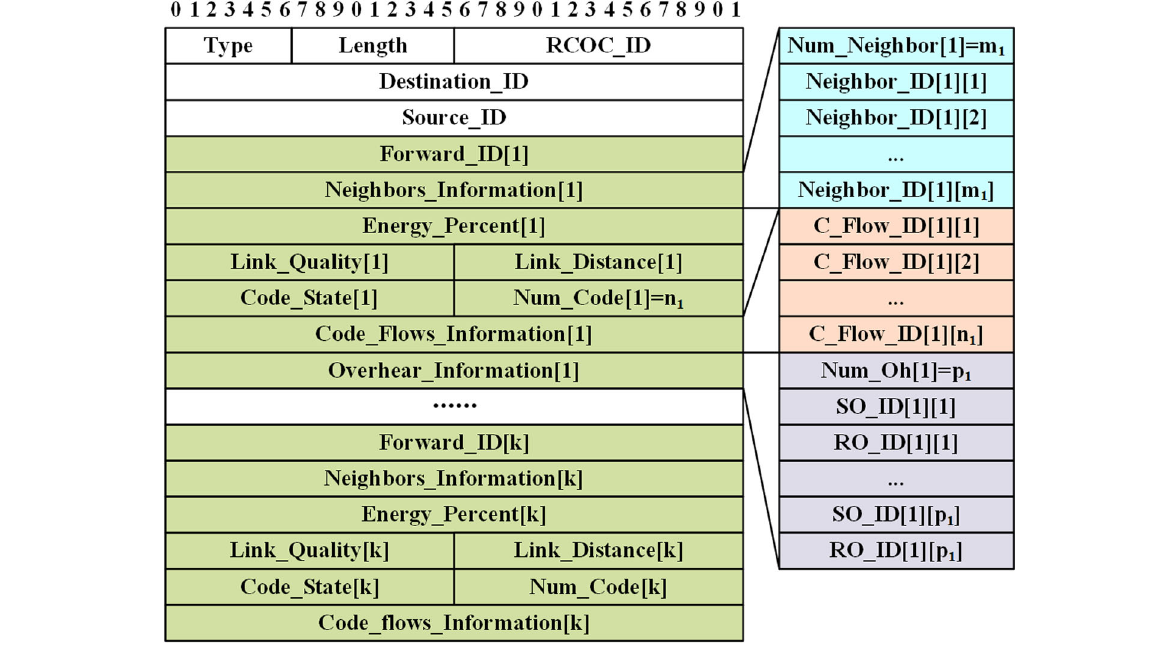
Fig. 14 Structure of RCOC Message. Figure 14 shows the structure of RCOC message, including the name of fields and their